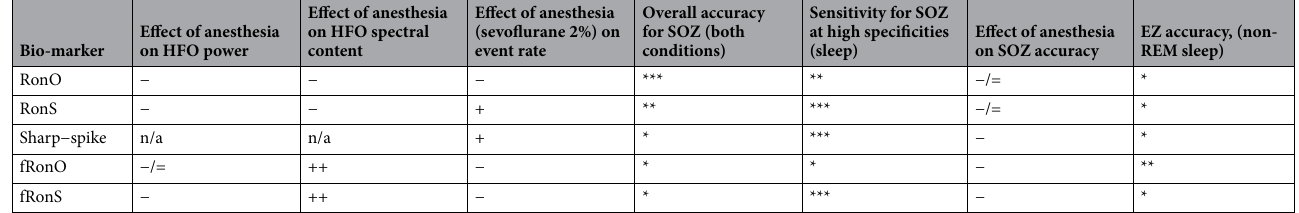
Table 3. Summary of findings. Minus sign indicates negative change, plus sign indicates positive change, minus and equals sign indicates negative trend, but no significant change. Single asterisk indicates relatively low value, double asterisk medium value, and triple asterisk relatively high